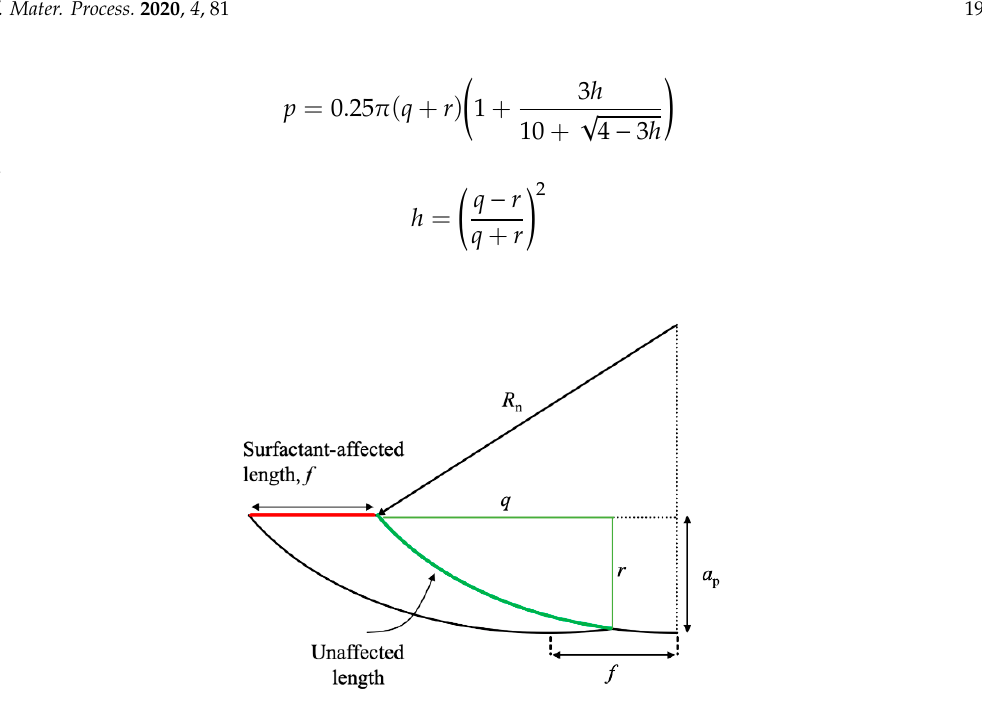
Figure A1. Front view illustration of the diamond turning process for the calculation of the unaffected material length.